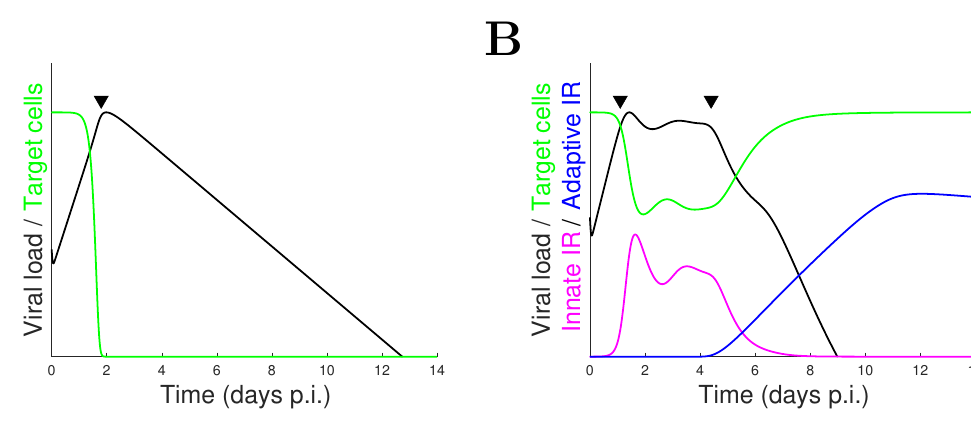
1 Figure 1. Schematic illustration of the typical solutions to the target cell-limited models ( A ) and models incorporating both innate and adaptive immune responses ( B ). For the target cell-limited models, severe depletion of target cells stops viral growth leading to viral clearance (the approximate turning point is indicated by a filled triangle). In contrast, for the models with both innate and adaptive immune responses, timely activation of the innate immune response stops viral growth and later activation of the adaptive immune response is responsible for viral clearance (the approximate times of activation are indicated by filled triangles). p.i.: